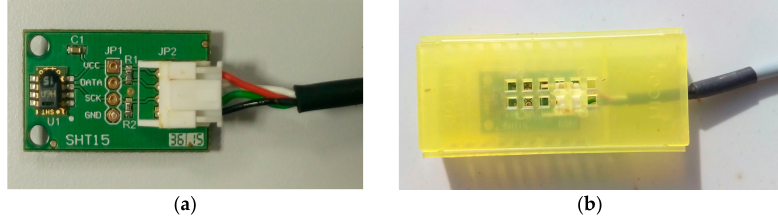
Figure 11. ( a ) SHT15 sensor mounted in PCB; ( b ) Cage for the protection of SHT15 sensors.